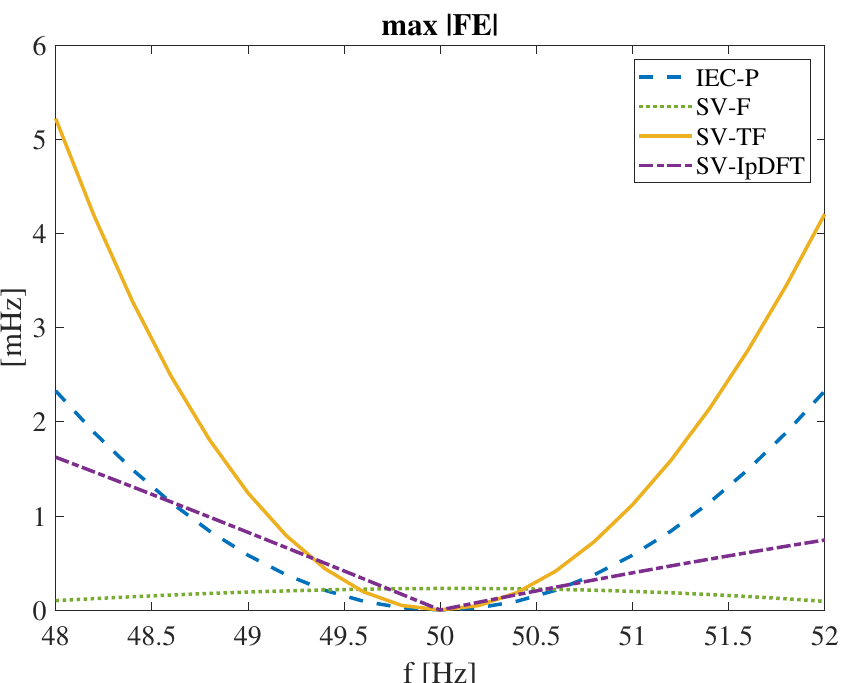
Figure 11. Maximum |FE| results under off-nominal frequency conditions in the presence of phase- angle unbalance.